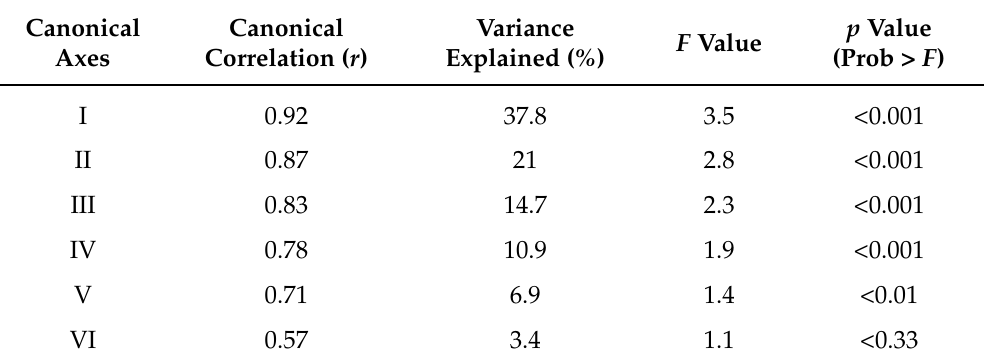
Table 3. Canonical correlation analysis of the PCOA and environmental/geographical variables in prairie cordgrass natural